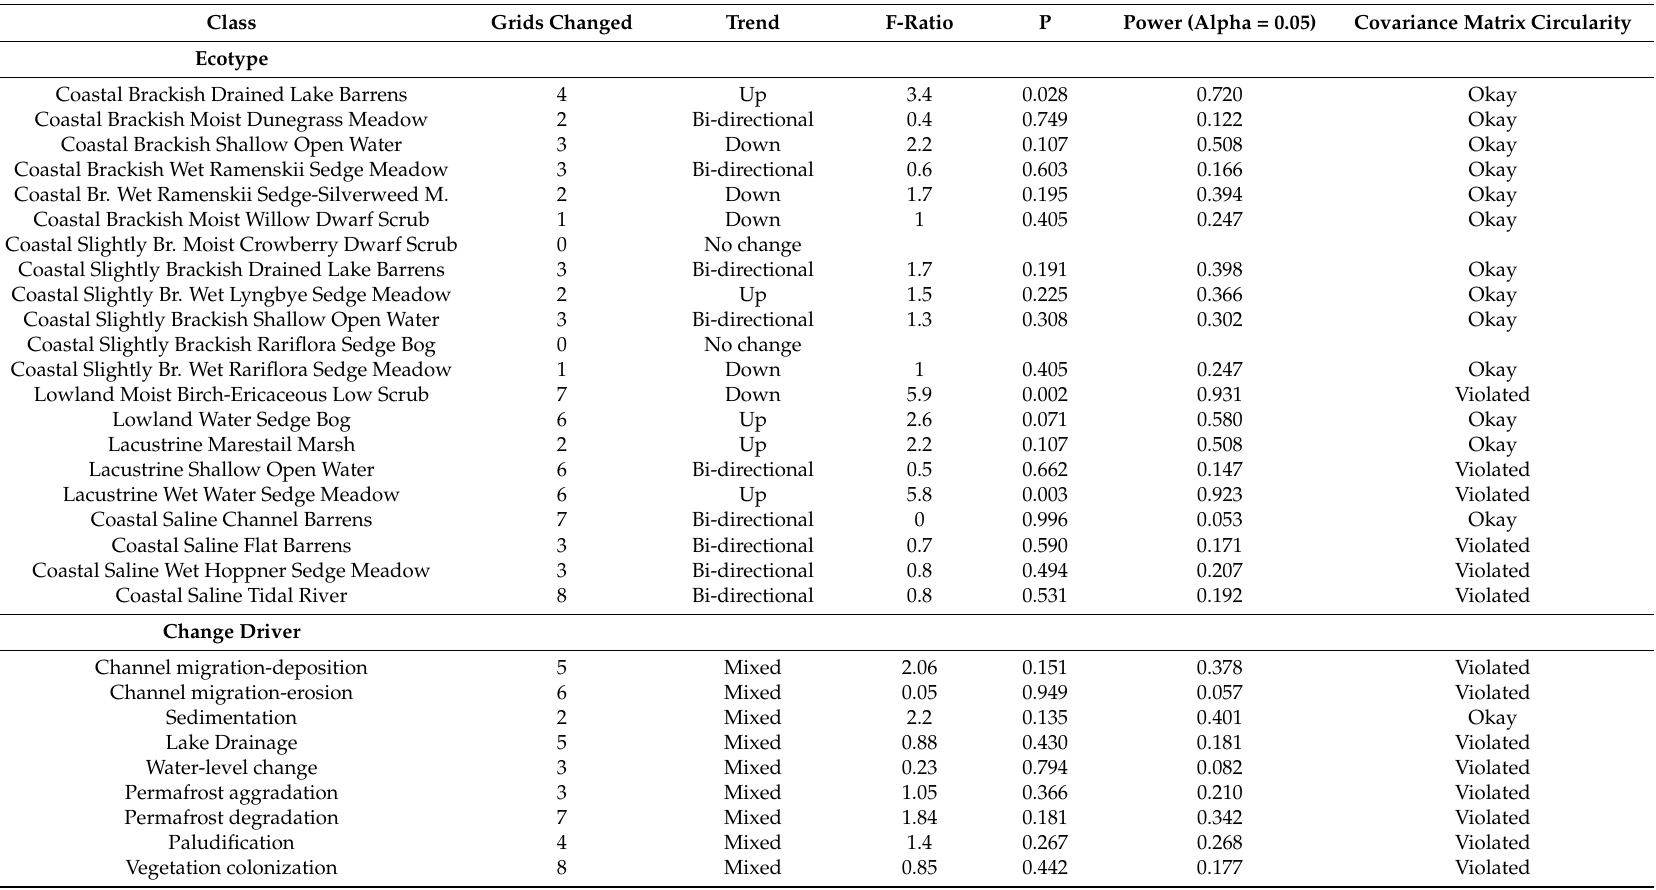
Table A4. Results of repeated measures ANOVA testing significance of ecotype changes across